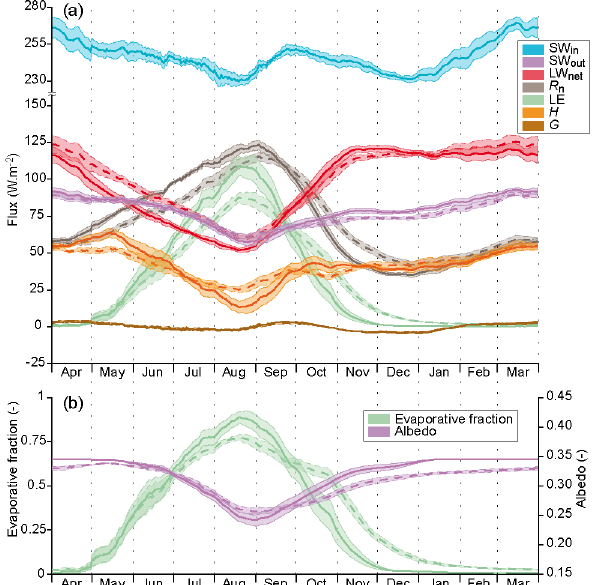
Figure 7. Estimated mean seasonal courses of energy cycle compo- nents, for fallow (solid lines) and millet (dashed lines) plots: (a) in- coming shortwave and outgoing fluxes; (b) evaporative fraction and albedo. See Eq. (1) for abbreviations and Fig. 6 for further explana- tion of curves and colored